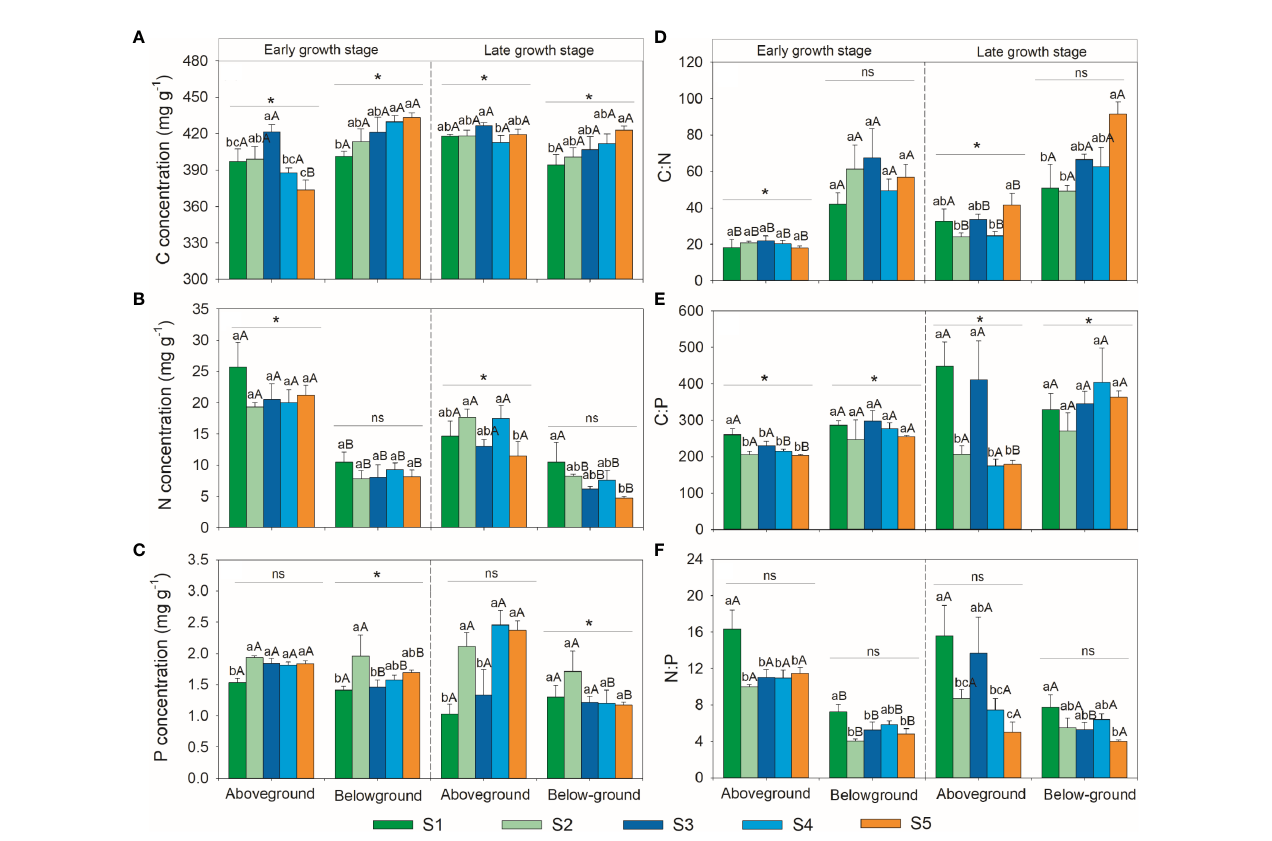
FIGURE 2 Variations patterns of herbaceous community C, N, P stoichiometries. (A) variation pattern of C concentration; (B) variation pattern of N concentration; (C) variation pattern of P concentration; (D) variation pattern of C:N ratio; (E) , variation pattern of C:P ratio; (F) variation pattern of N:P ratio. S1, very low salinity; S2, low salinity; S3, medium salinity; S4, high salinity; S5, very high salinity. Different uppercase letters indicate signi fi cant differences between above- and below-ground parts of the same growth stage. Different lowercase letters indicate signi fi cant differences amongst plots in the same part within growth stage. * and ns indicate signi fi cant and no signi fi cant differences in the same part between growth stages,